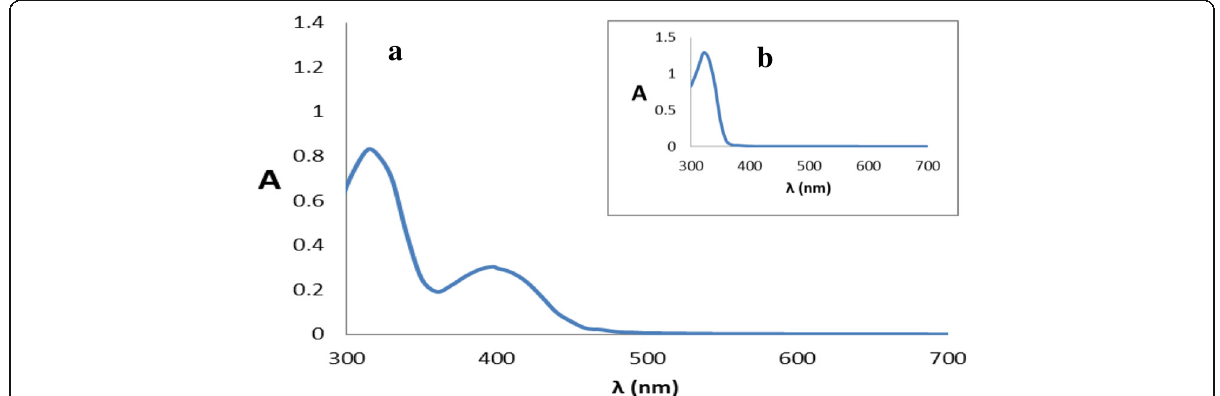
Fig. 1 The absorption spectra for a Cu-salophen complex and b salophen ligand. Conditions: a Cu(II) concentration, 5.0 × 10 − 5 M; salophen concentration, 2.5 × 10 − 4 M; solvent, water; pH = 2.0; b salophen concentration, 2.5 × 10 − 4 M; solvent, water; pH =